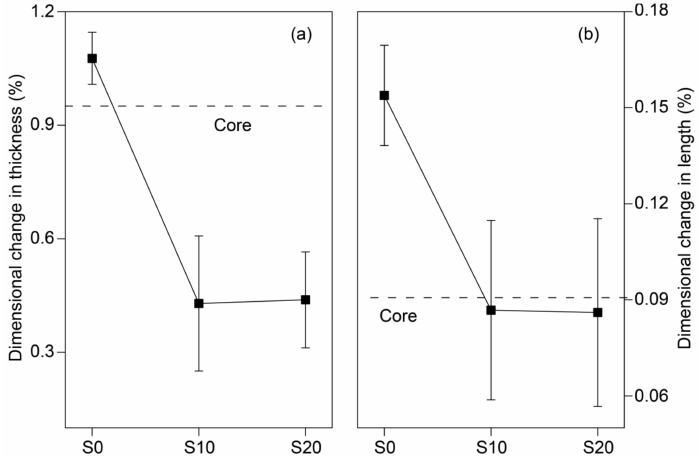
Figure 7. Thermal expansion strain of the entire Co-WPCs with nSiO 2 filler in the shell in the thickness ( a ) and length directions ( b